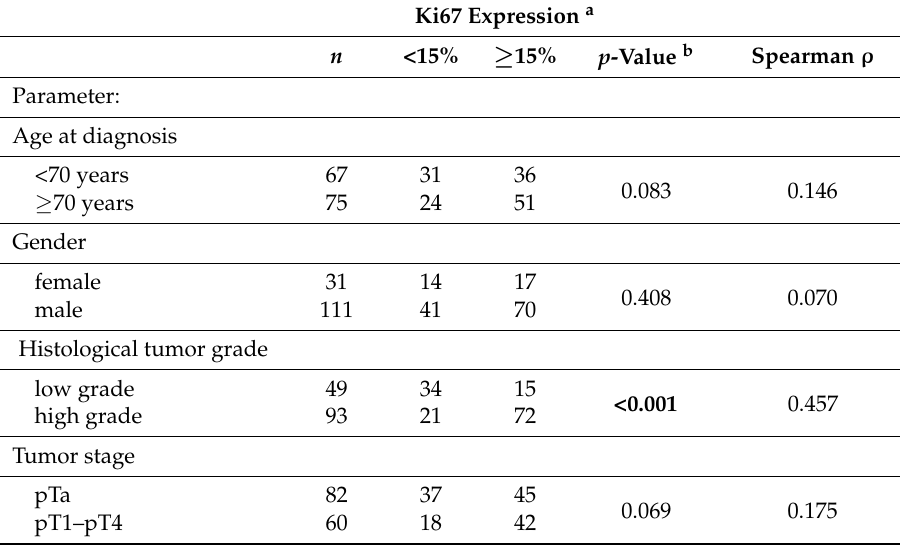
Table 2. Clinico-pathological parameters in correlation to Ki67 protein